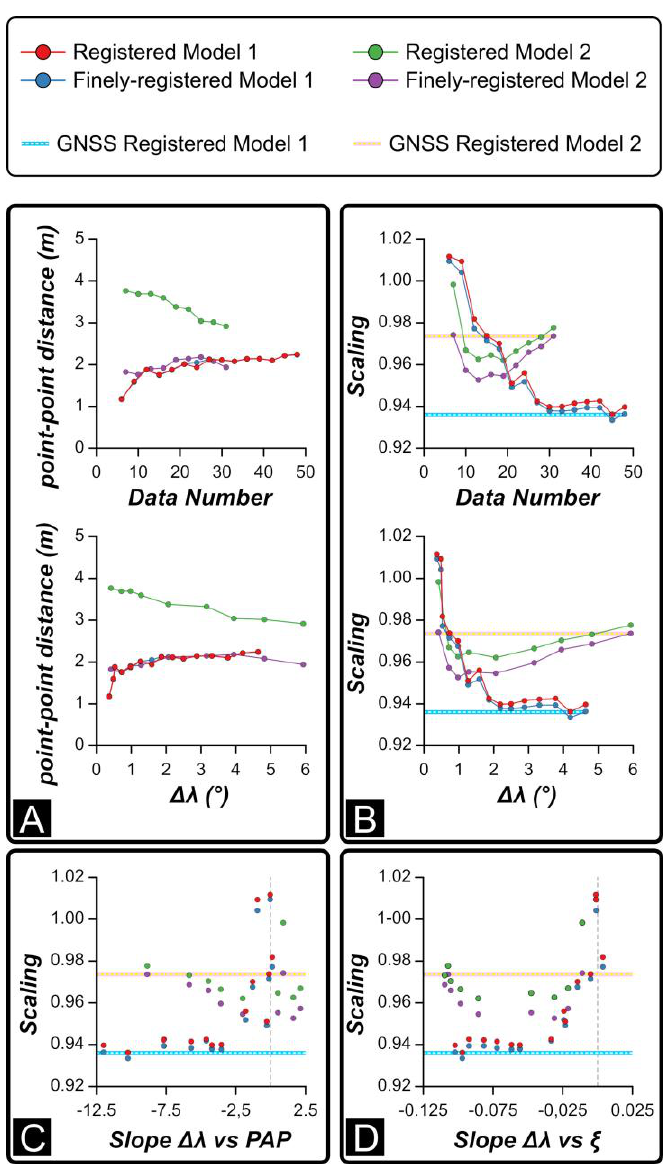
Figure 9. Mismatch between registered and ground truth smartphone models for the different sub-models. The mismatch includes: ( A ) the average distance between measured and reconstructed camera position and ( B ) scaling needed to accurately align the smartphone sub-models to the corresponding ground truth model. Scaling is also compared with the slope of the best fit lines of ∆ λ vs ( C ) position along diagonal path and ( D ) view direction (as shown in Figure 7). The plots also include the mismatch between the ground truth models and the model registered using the GNSS position (without using camera orientation